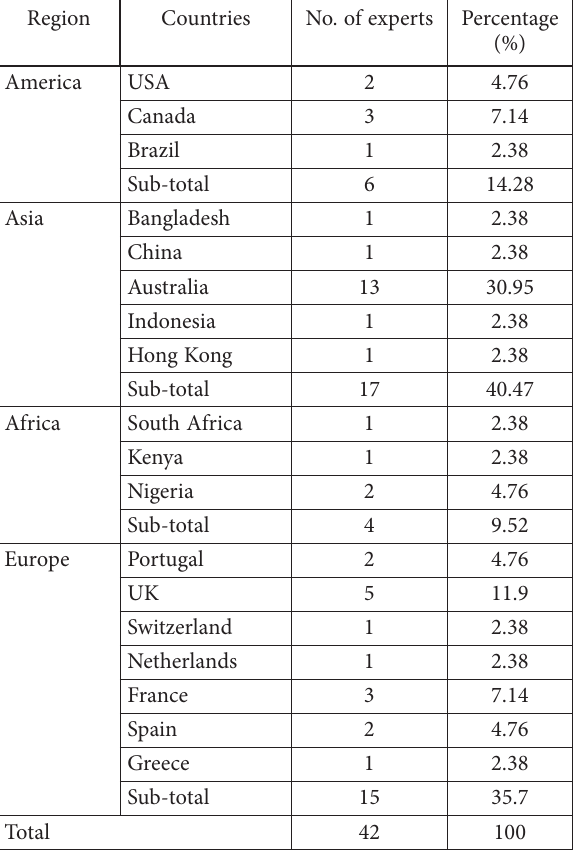
Table 4. Countries of experts (Osei-Kyei & Chan, 2017) Region Countries No. of experts Percentage